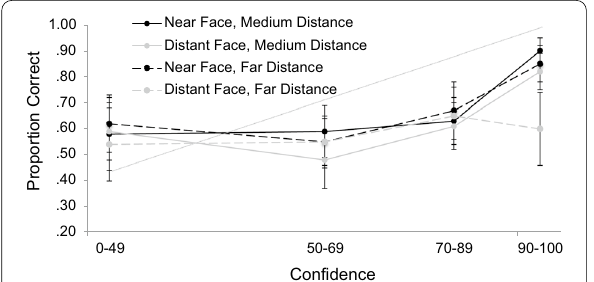
Fig. 4 Calibration Curves for Faces that were Presented at a Near or Simulated Distance (Medium or Far) in Experiment 2. Note: The diagonal line indicates optimal calibration. Bars represent descriptive 95% confidence